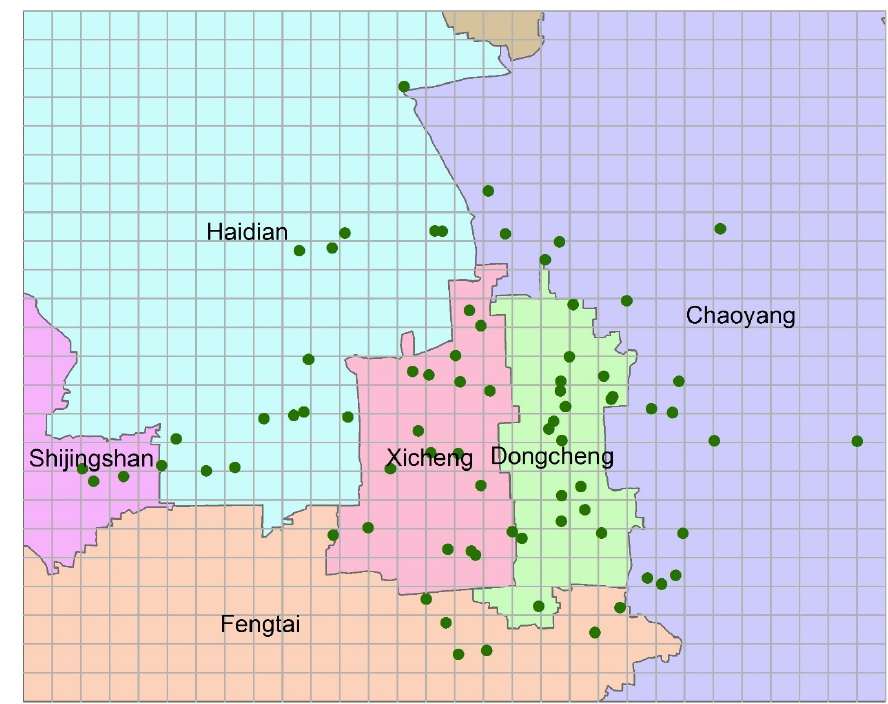
Figure 2. Spatial distribution of hospitals in the study area.